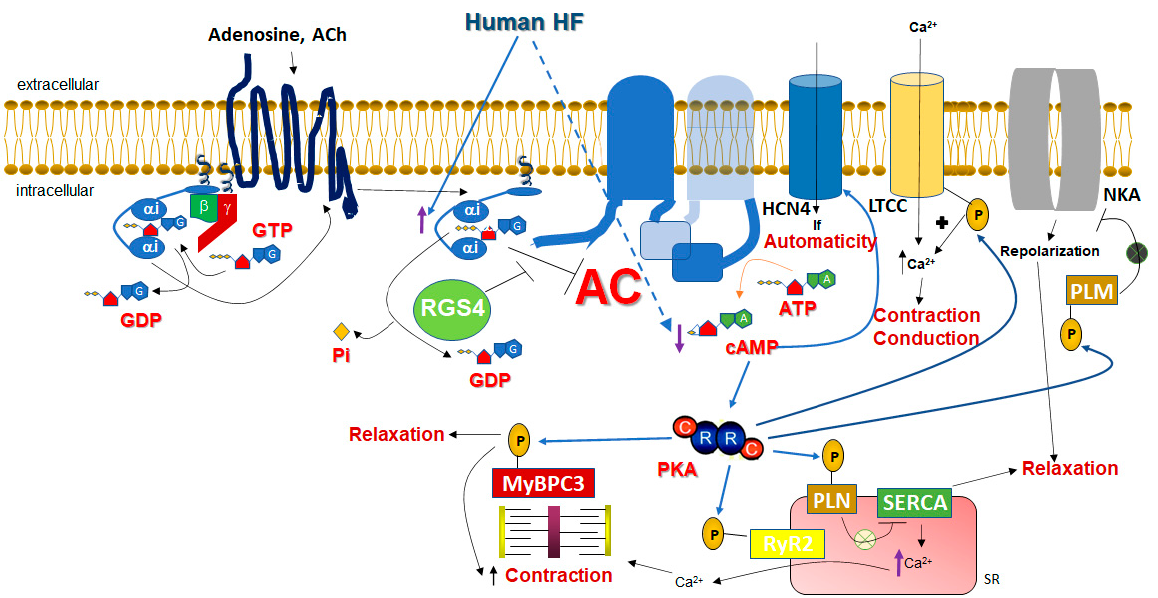
Figure 1. Role of cardiomyocyte RGS4 in the context of human HF. G α i activity is high and cAMP levels are low in the failing human heart. Phosphorylation of MyBPC3 by PKA first increases contraction before it facilitates relaxation of the actin-myosin fibers. ACh: acetylcholine; AC: adenylyl cyclase; Pi: inorganic phosphate; P: phosphorylation; NKA: Na + /K + -adenosine triphosphatase (sodium pump); PLM: phospholemman; PLN: phospholamban; ATP: adenosine triphosphate; SR: sarcoplasmic reticulum; SERCA: sarco(endo)plasmic reticulum calcium adenosine triphosphatase; A: adenine; G: guanine; R: regulatory subunit of PKA; C: catalytic subunit of PKA. See text for details and all other molecular acronym descriptions.